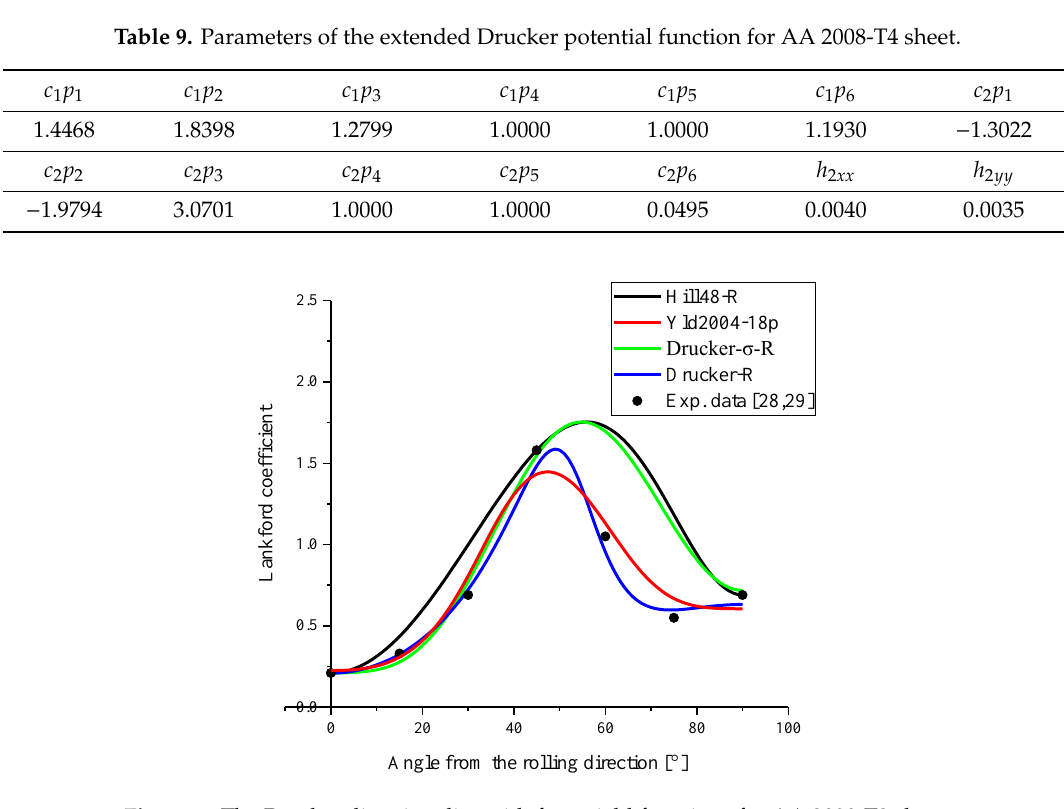
Figure 8. The R-value directionality with four yield functions for AA 2008-T4 sheet. 6.2. Application to Zirconium Plate with Significant SDE The developed Drucker yield function formulated in Section 3 is applied to predict the yield surface evolution of a clock-rolled Zirconium plate with significant SDE. A series of clock-rolling and annealing processing cycles were carried out, resulting in typical basal texture (where